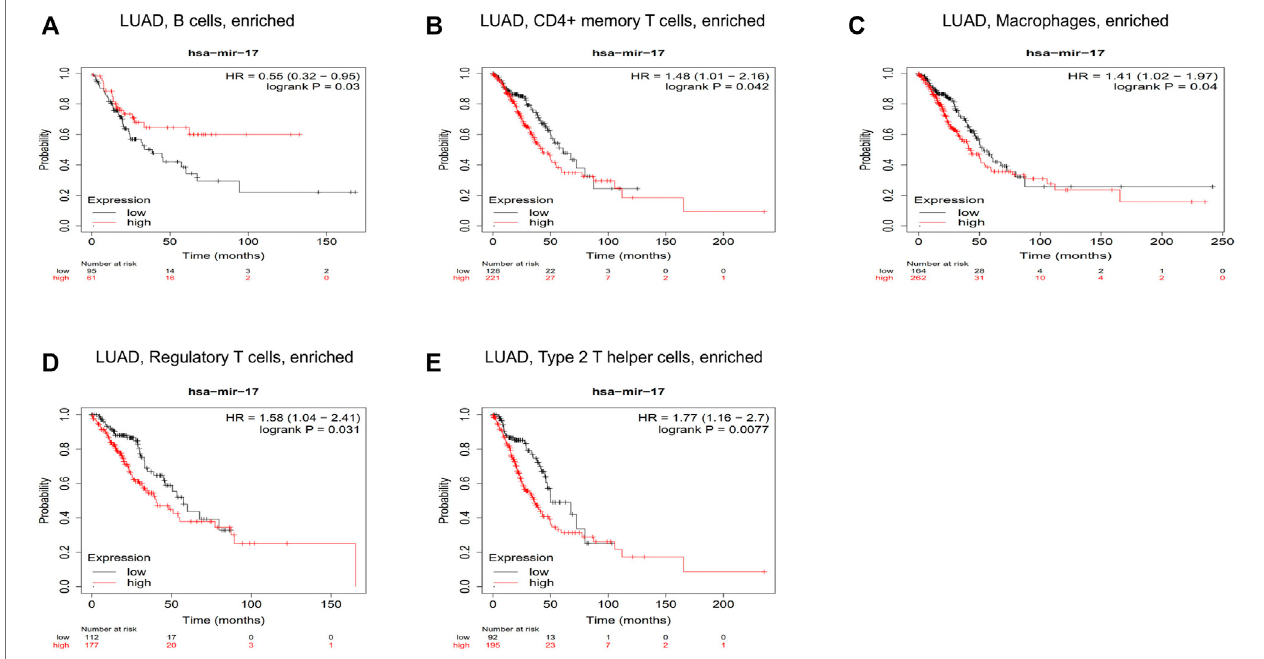
FIGURE7 | Correlations between hsa-miR-17 expression and immunein fi ltration in LUAD. Kaplan – Meiersurvivalcurvescompared between over-expression and down-expression of hsa-miR-17 in LUAD on the basis of immune cells subtypes. Association between LUAD of different immune cells subtype and prognosis (A – E) .